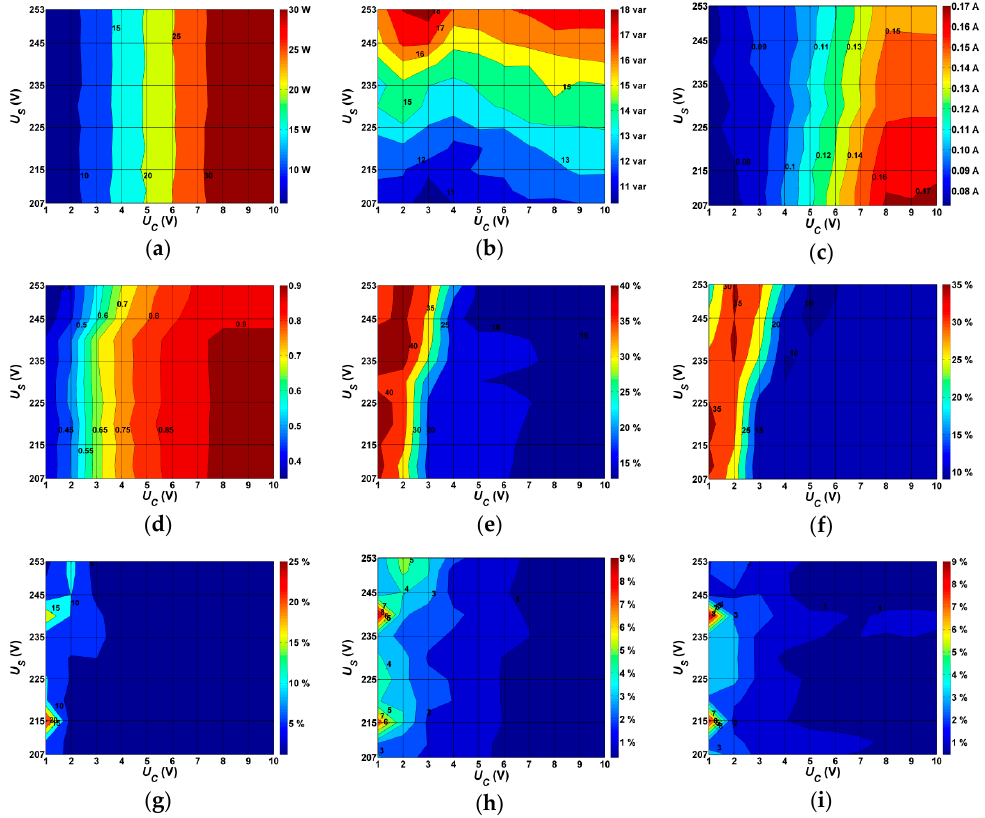
Figure 1. Measured electrical parameters of the luminaire: ( a ) active power P ; ( b ) reactive power Q ; ( c ) I RMS ; ( d ) displacement power factor PF D ; ( e ) THD I ; ( f ) I h3 ; ( g ) I h9 ; ( h ) I h15 ; ( i ) I h21 .